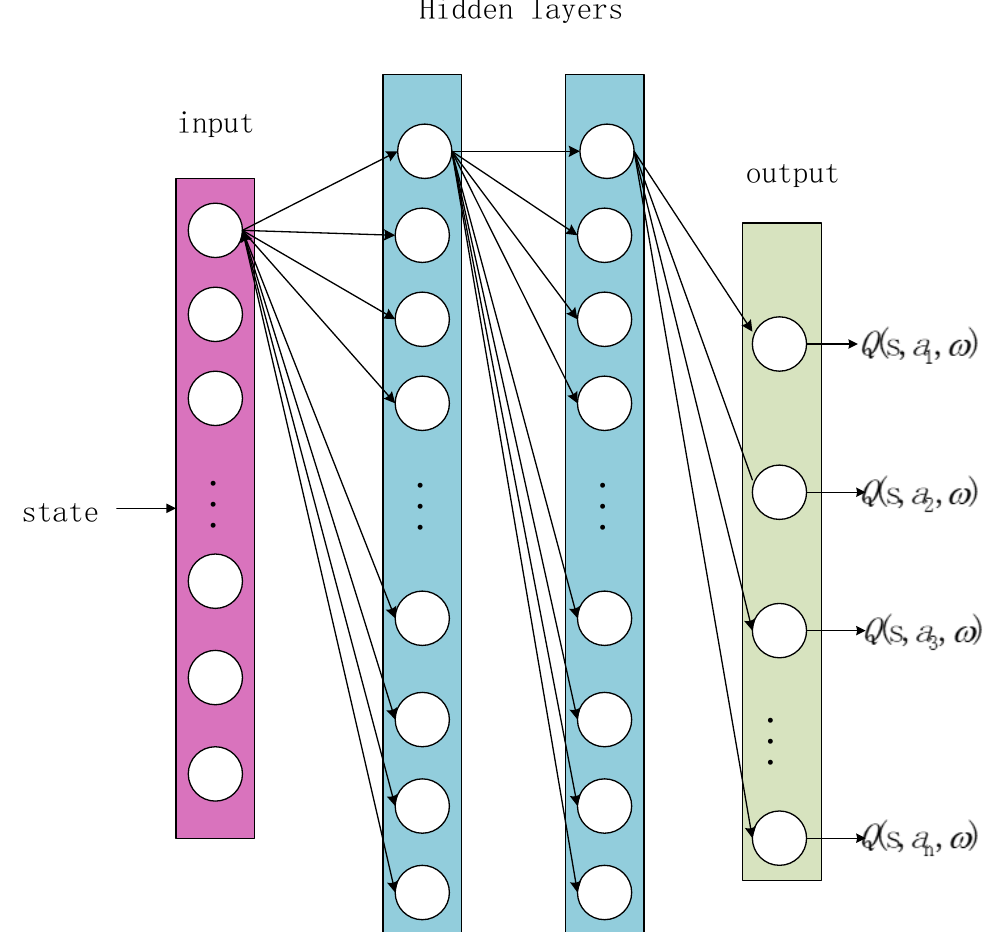
Figure 5. Neural network value function approximation.